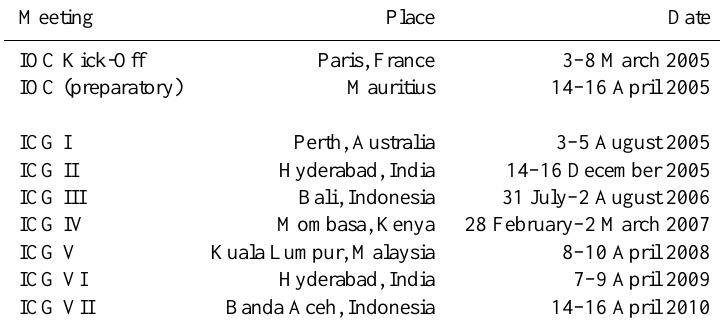
Table 1. List of IOC IOTWS ICG meetings, places and dates.